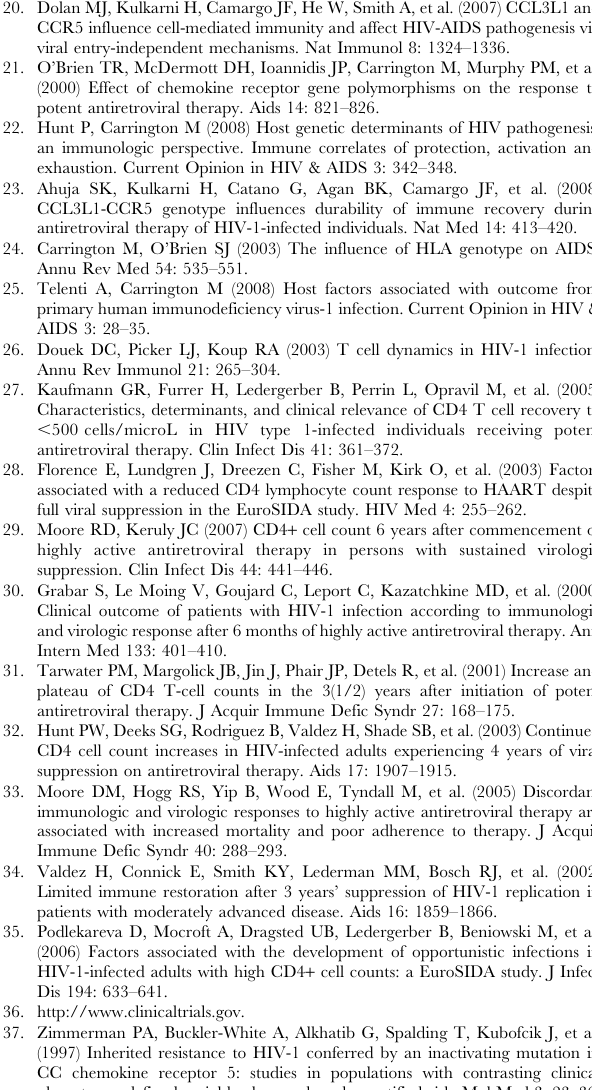
Figure S1 Classification trees and their clinical application in the HIV + WHMC cohort. Figure S2 Replication of results of CART analysis in the seroprevalent component of the WHMC HIV + cohort.